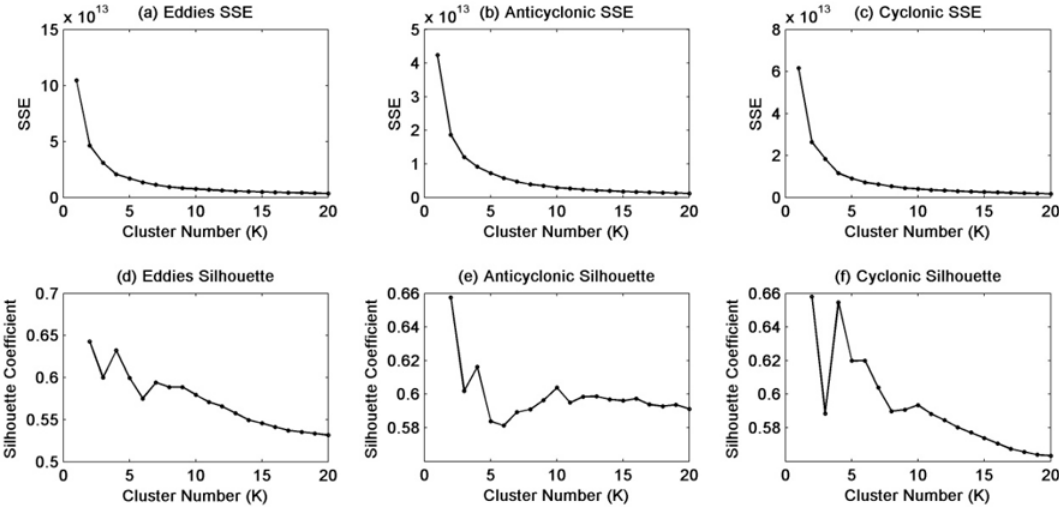
Fig. 3. Plots of sum of squared error and silhouette